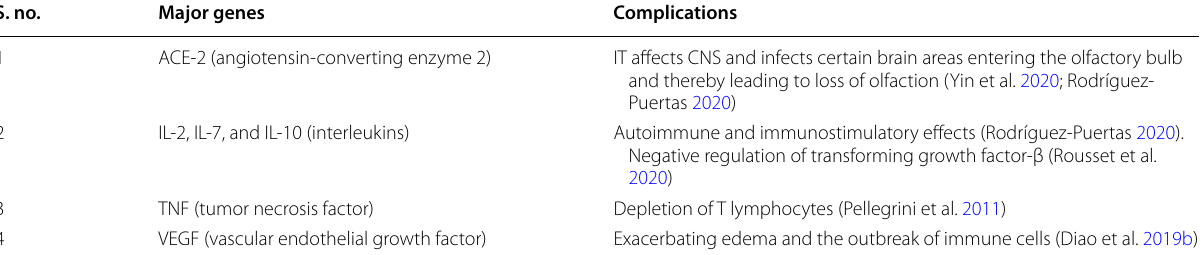
Table 3 Significant genes with their expression on SARS-CoV-2 S.